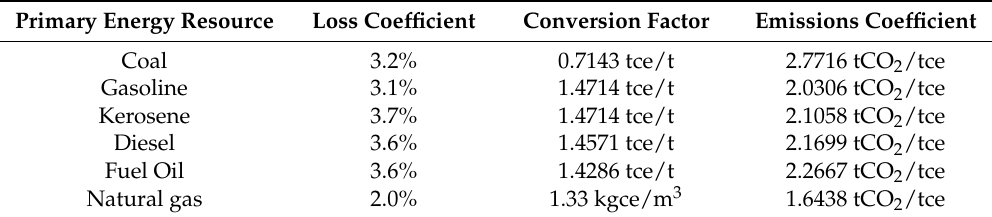
Table 2. The conversion factors and emission coefficients of fossil fuels.